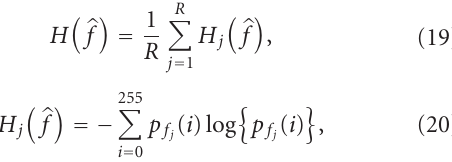
value i . To estimate the NA 1 term, (cid:2) f is divided into j (1 to R ) subimages of size 16 × 16 pixels. NA 1 (19) is calculated as the average of the entropy of the subimages (20).